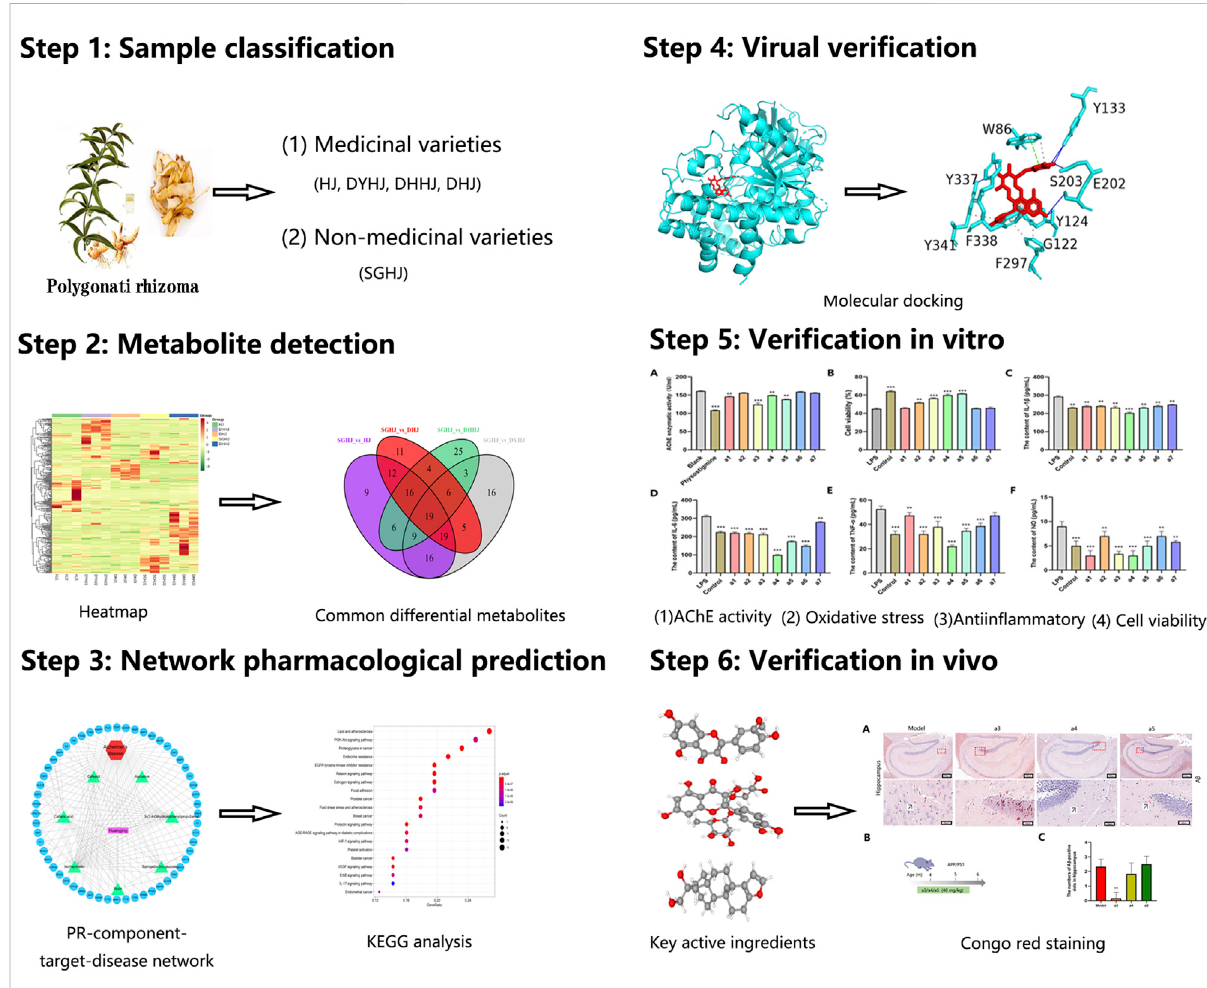
FIGURE 1 The integrated strategy of comparative metabolomics and network